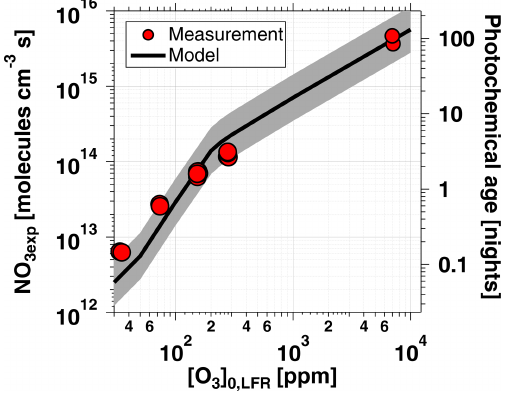
Figure 5. NO 3exp as a function of [O 3 ] 0 , LFR for measure- ments with [NO 2 ] 0 , LFR : [ O 3 ] 0 , LFR = 0 . 5 ± 0 . 1. Equivalent am- bient photochemical age was calculated assuming a 14h aver- age nighttime NO 3 mixing ratio of 30ppt and 10h daytime aver- age NO 3 mixing ratio of 0ppt (Asaf et al., 2010). Model inputs = 0 . 01s − 1 and NO = 0 . 07s − 1 ( [ O ] were k w , N 3 R ext 3 0 , LFR < 2 O 5 1000ppm) or 0.38s − 1 ([O 3 ] 0 , LFR > 1000ppm). The shaded re- gion encompasses model output scaled by factors of 0.5 and 2.